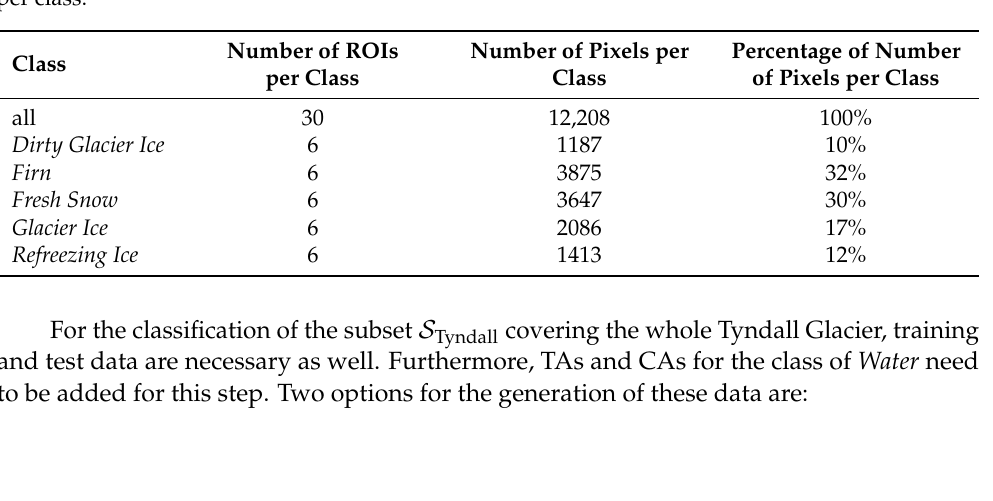
Table 2. Characteristics of the test data in terms of the number of areas (ROIs) and number of pixels per